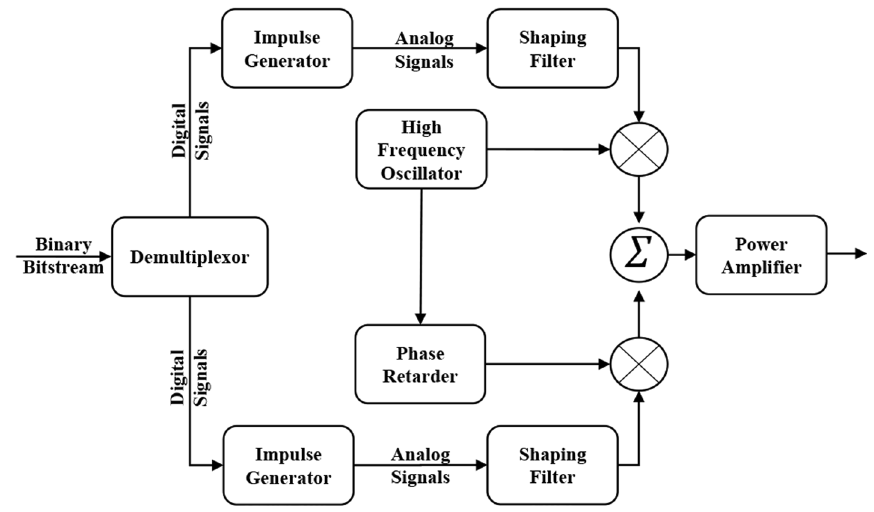
Fig. 3 Structure of an MPSK communication